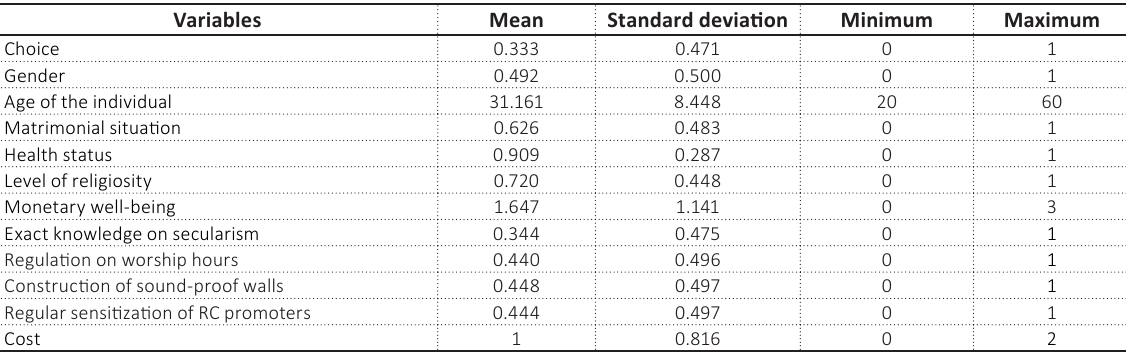
Table 4. Elements of descriptive